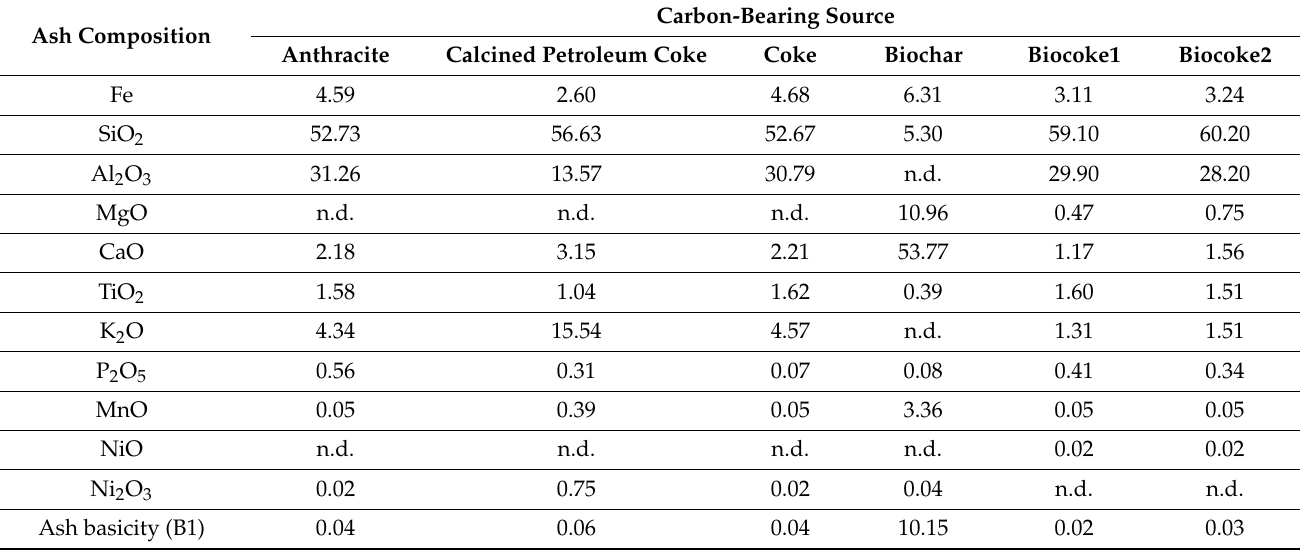
Table 3. The XRF results of ash composition of carbon-bearing sources (wt.%